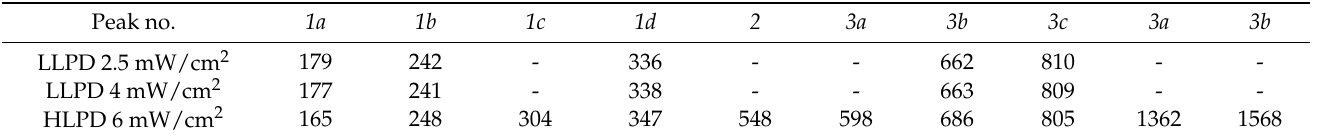
Table 1. Values recorded for the Raman peaks observed in the three Raman experiments in LLPD and HLPD annealing